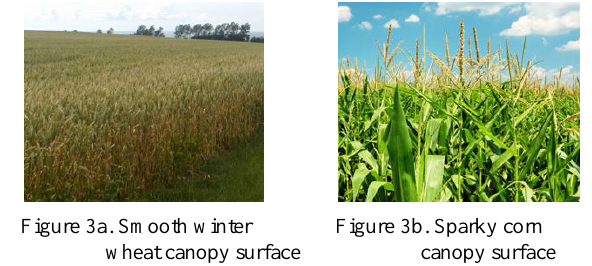
figure 5. Figures 3a and 3b illustrate the differences with examples from winter wheat and corn.